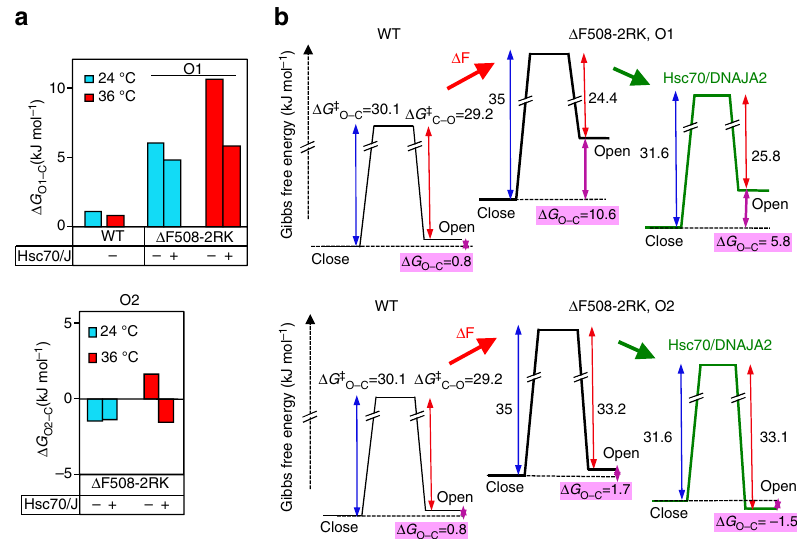
Fig. 6 Molecular chaperones reshape the transition and open state gating energetics of Δ F508-CFTR during thermal unfolding. a , b Equilibrium Gibbs free energy differences ( Δ G O – C ) between the open (O1 and O2) and closed (C) states were calculated from the difference of the opening and closing activation energies ( Δ G O – C = Δ G ‡ O – C − Δ G ‡ C – O , Supplementary Table 4). Δ G ‡ O – C and Δ G ‡ C – O were determined from the gating kinetics of single channels at 36 °C as described in Methods. b Schematic representation of the gating energetics of WT and Δ F508-CFTR-2RK in the absence or presence of Hsc70/DNAJA2 at 36 °C based on calculation described in a . Hsc70/DNAJA2 predominantly decreases the opening activation energy of the Δ F508-2RK. The closed state folding free energy of Δ F508-CFTR-2RK after thermal unfolding relative to WT is arbitrarily chosen. The Δ G O – C values are derived from